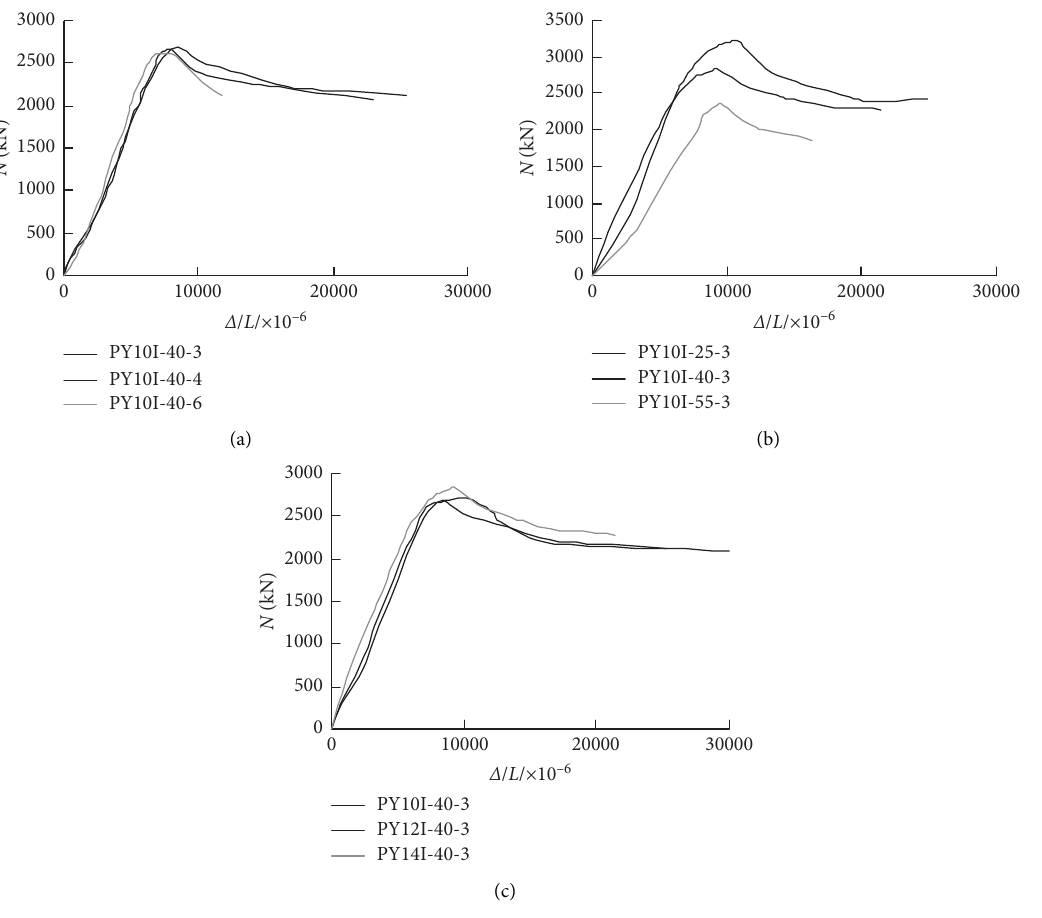
Figure 9: Influence of parameters on N - Δ : (a) slenderness ratios, (b) eccentricities, and (c) steel section